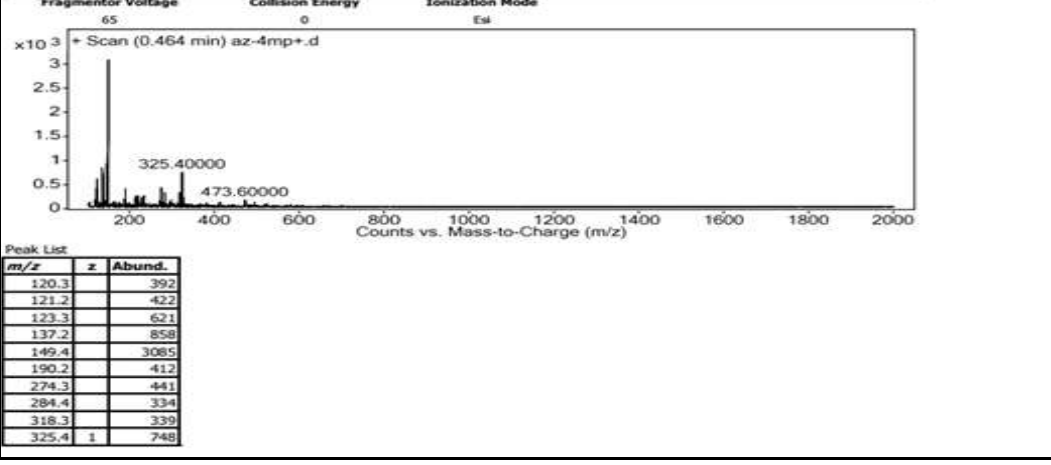
Figure 13.LC/MS for isolated compound A1 The compounds detected in chloroform fraction for capsule of Cynara scolymus show in Table7 and Table 7. GC/MS analysis of the chloroform fraction of Cynara s